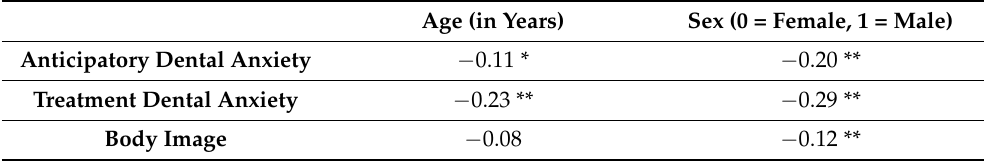
Table 3. Table of parameters (standardized) for full